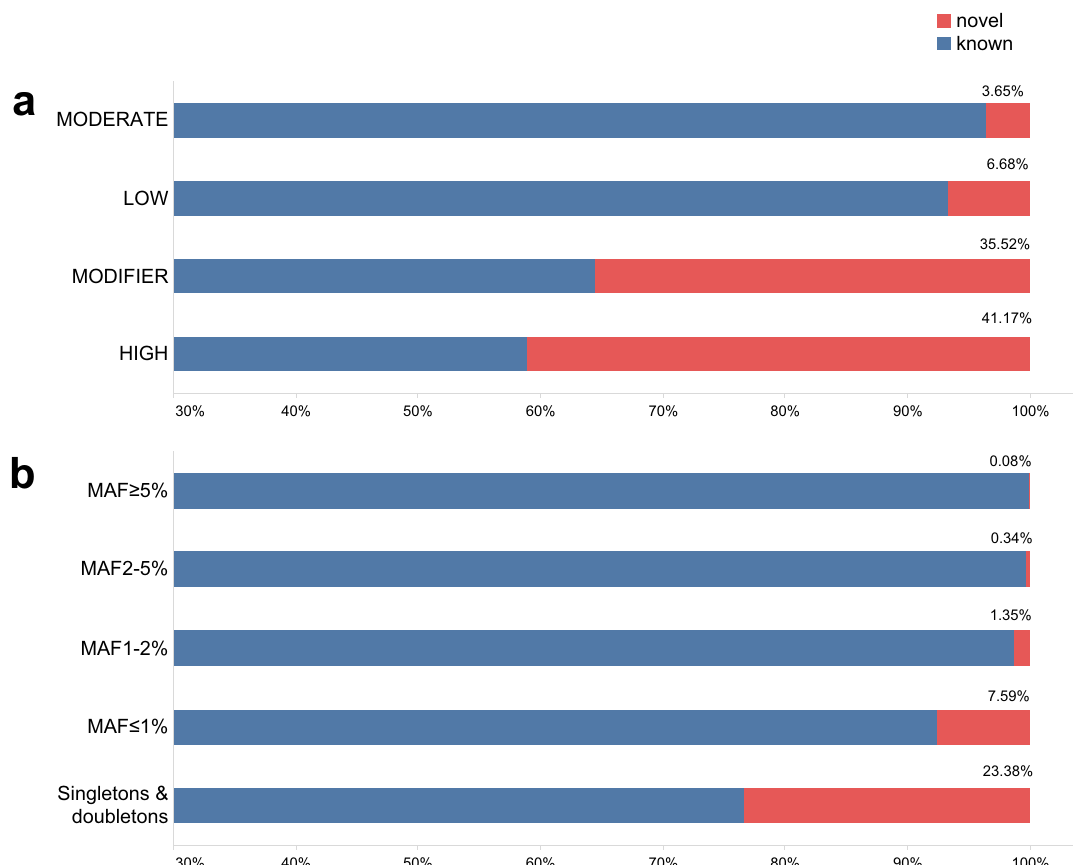
Figure 6. Novel variants in the Serbian population sample classified by predicted functional impact. (a) Percent of novel variants by functional impact relative to known variants found in all databases after intersection. ( b) Percent of novel variants distributed across allele frequency